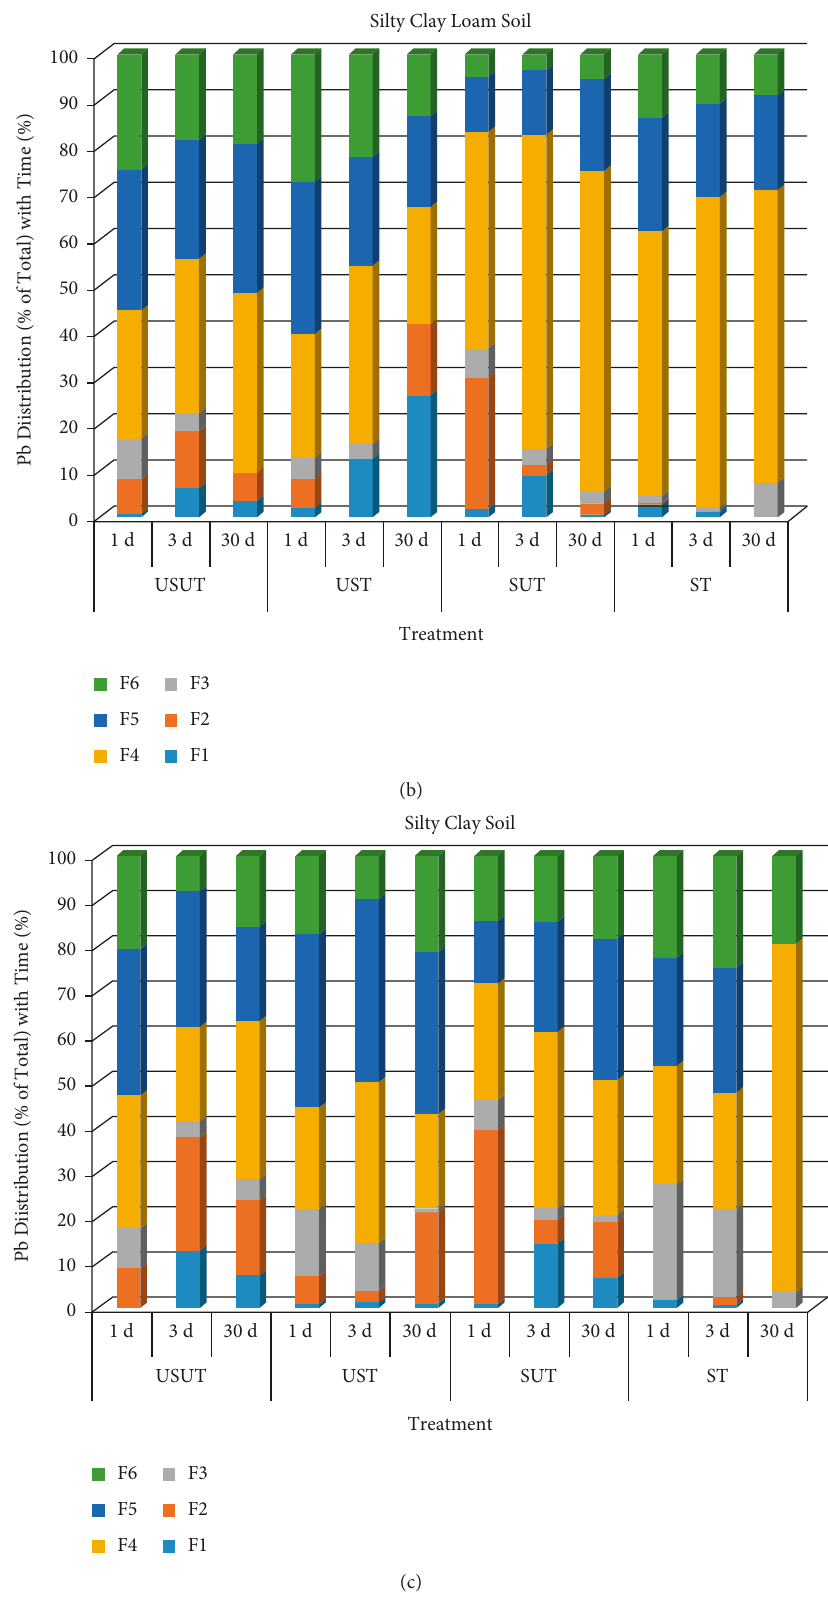
Figure 2: Speciation of lead into different fractions of three soils (a, b, c) in relation to time and different treatments; USUT- unspiked untreated, UST- unspiked treated with OM, SUT- spiked untreated with OM, ST- spiked treated with